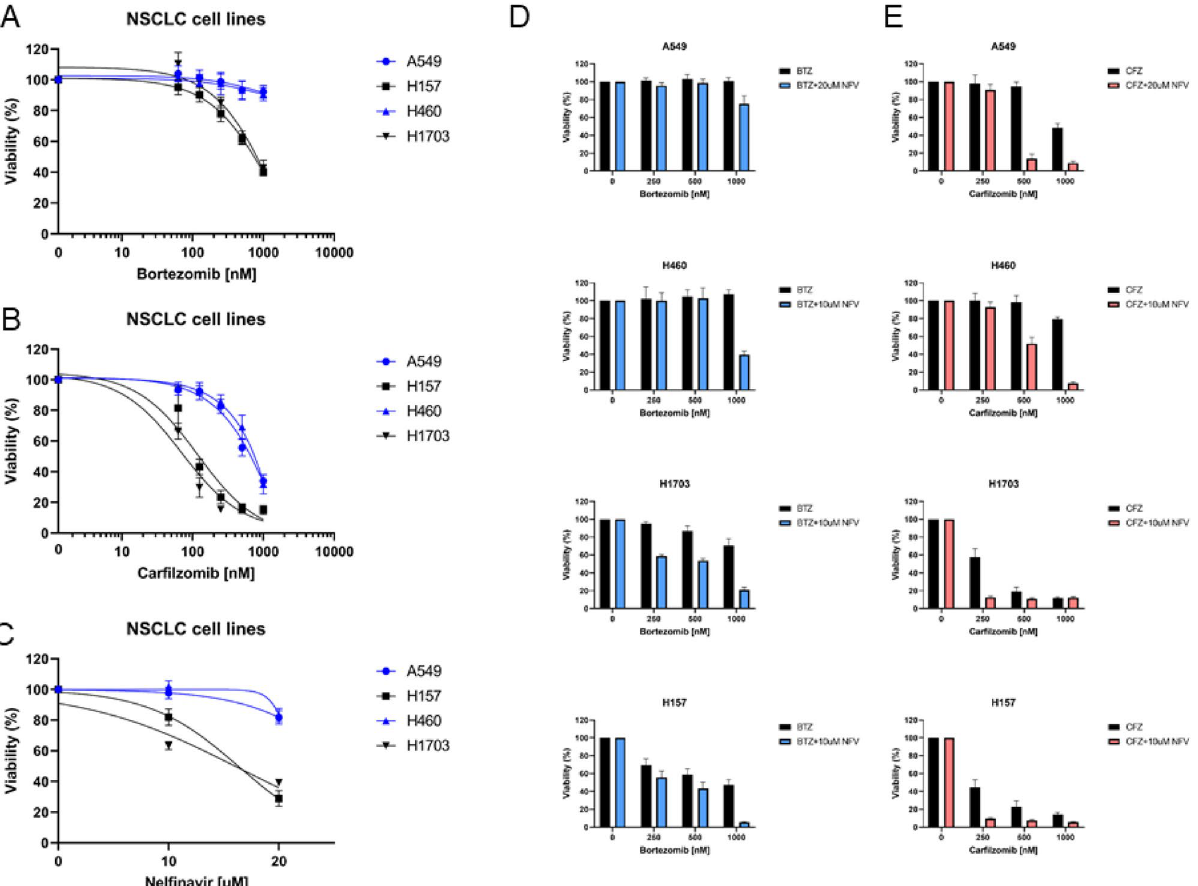
Figure 1. Cytotoxicity of proteasome inhibitors alone or in combination with nelfinavir in NSCLC cell lines. Cell viability assays (MTS) were performed with NSCLC cell lines A549 (adenocarcinoma), H460 (large cell lung cancer), H157 (squamous cell carcinoma) and H1703 (adenocarcinoma), and dose ‒ response curves were obtained to calculate the IC50 values for the drugs in all cell lines (presented in Table S1). Cells were treated with increasing concentrations of ( A ) bortezomib and ( B ) carfilzomib for two hours, washed, and then left in drug-free medium for an additional 48 h. ( C ) Cells were treated with increasing concentrations of nelfinavir continuously for 48 h. Data represent the mean ± SD of at least three replicates. Escalating doses of ( D ) bortezomib and ( E ) carfilzomib were added for 2 h. After washing away proteasome inhibitors, nelfinavir was added for an additional 48 h at a concentration of 10 µM, except for A549 cells, where a concentration of 20 µM was used. The synergistic effect for drug combinations was calculated, and the most significant synergy is presented in Table S2. Data represent the mean ± SD of at least three